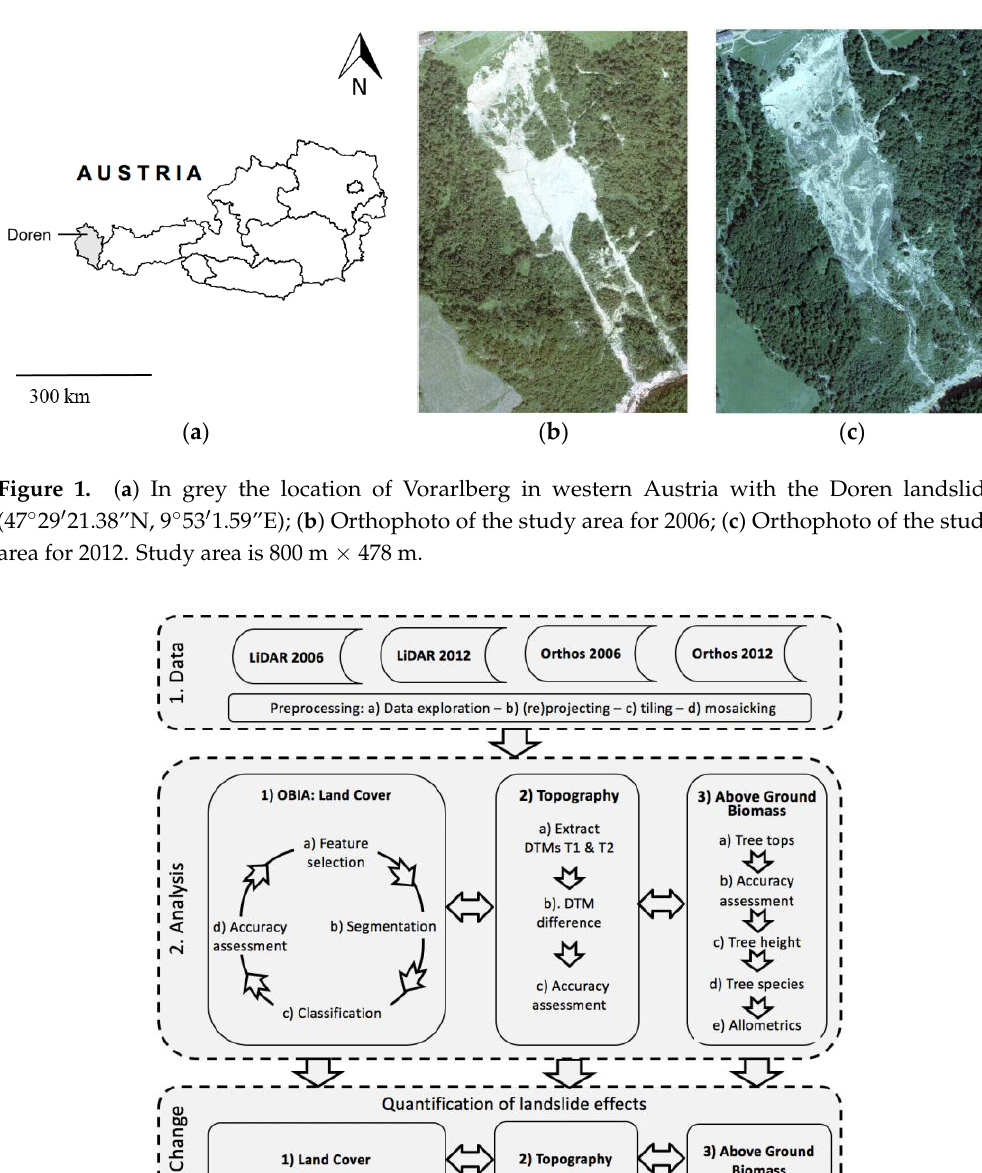
Figure 2. The workflow consists of three main sections; (1) Data, which includes data preprocessing, (2) Analysis and (3) Change. Two way horizontal arrows indicate use of data synergy. In Section 2. Analysis, data synergy is utilized to improve the accuracy of the landscape change analysis. In the Section 3. Change data synergy is used to improve interpretation of the